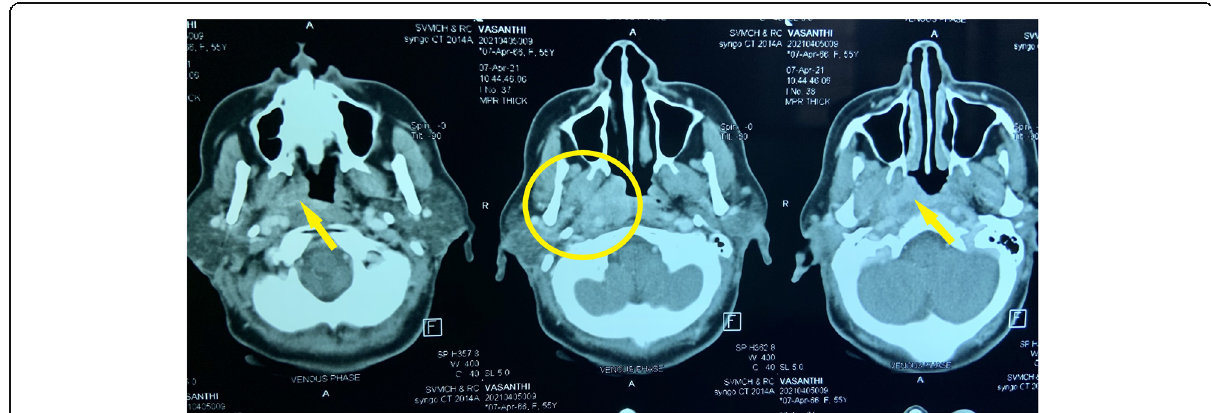
Fig. 2 Contrast enhanced computerised tomography shows ill-defined hypodense mass lesions in the right lateral wall of nasopharynx extending to midline causing nasopharyngeal airway narrowing. The lesion involving the fossa of Rosenmuller, torus tubaris with involvement of eustachian tube. It is also abutting lateral pterygoid muscle with loss of fat plane; inferiorly it is entering the parapharyngeal space in right side. Slight